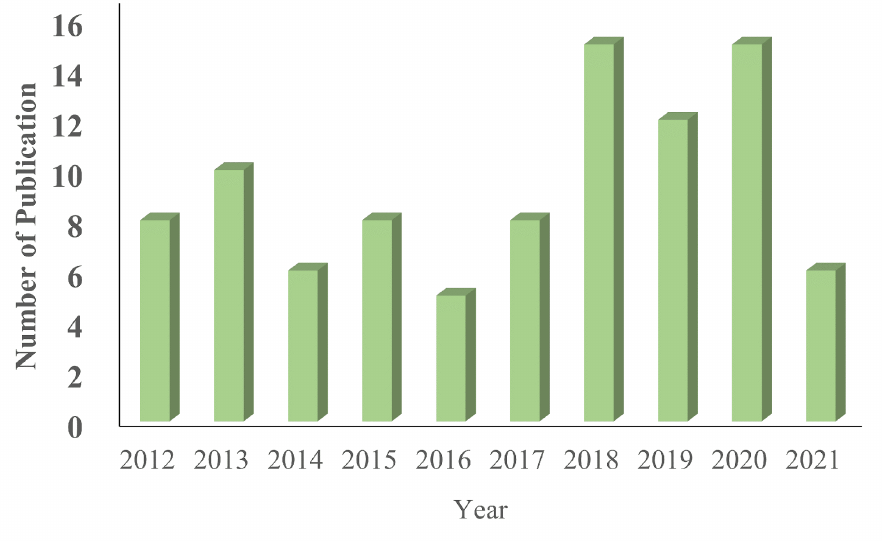
Figure 3. The number of peer-reviewed publications in relation to the year of